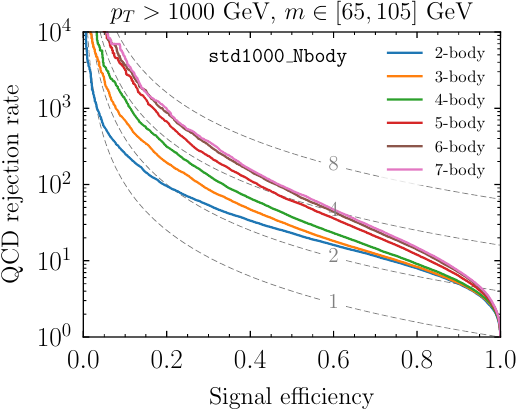
Figure 7 . Signal e(cid:14)ciency versus background rejection for di(cid:11)erent versions of the std1000 tagger taking M = 2 ; : : : ; 7 in eq.